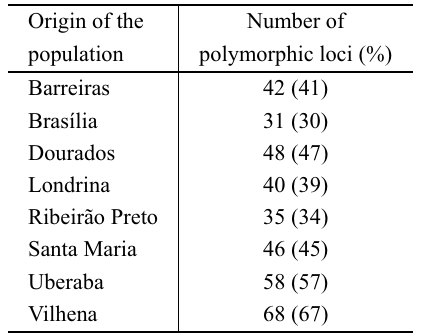
Number of polymorphic bands produced by the primers used for the caracterization of Chlosyne lacinia saundersii